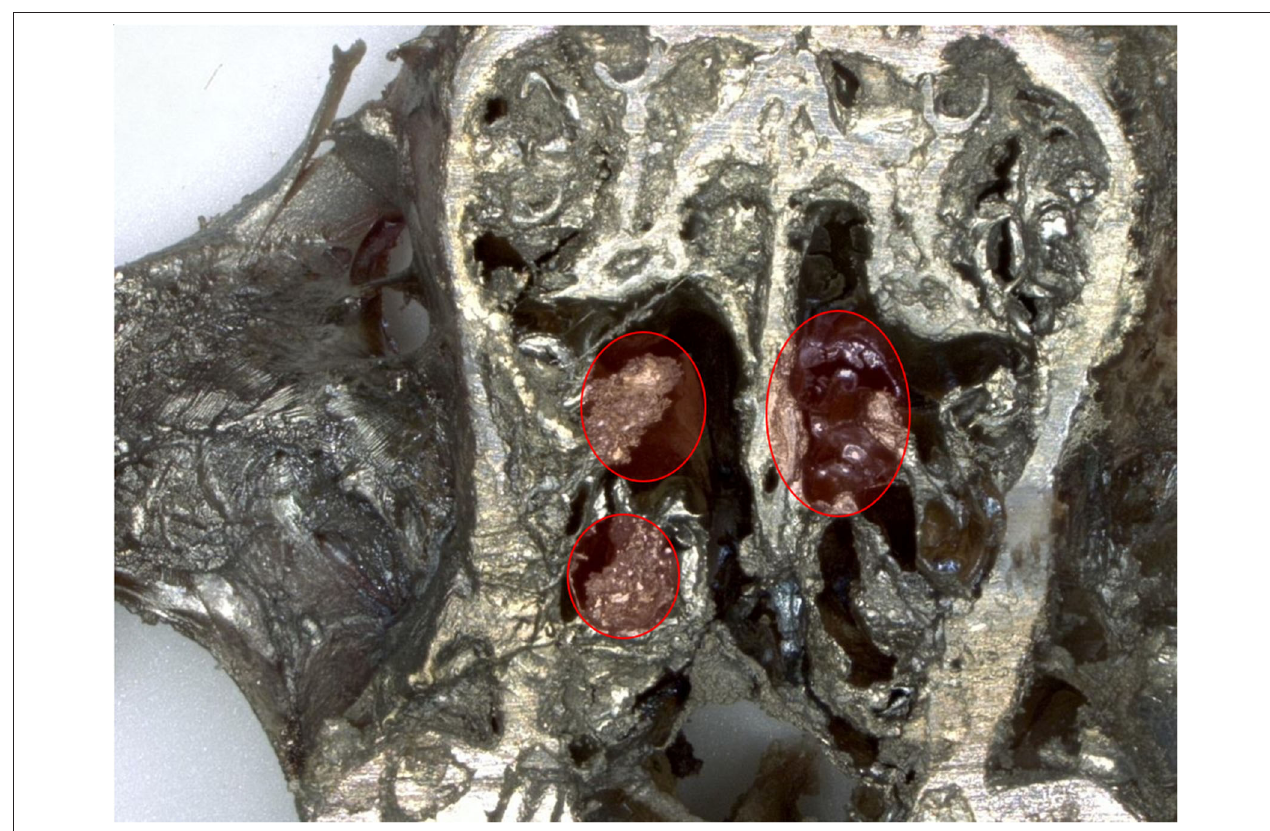
FIGURE 3 | Male rat. Deceased after 2 ¾ h after start of inhalation. Nasal cavity level 4 (frozen, dried, sputtered sample): partial blockage by deposited test item. Digital microscopy, lens